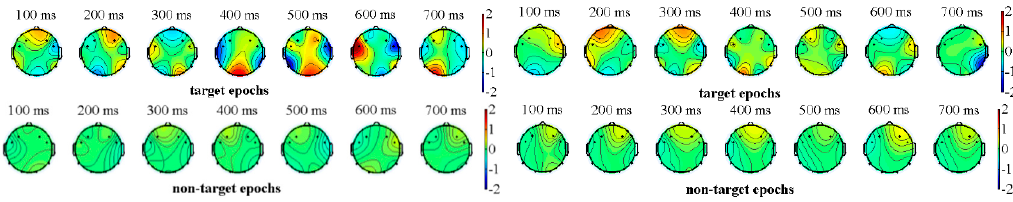
Figure 3. Comparison of the original brain wave and denoising brain wave.